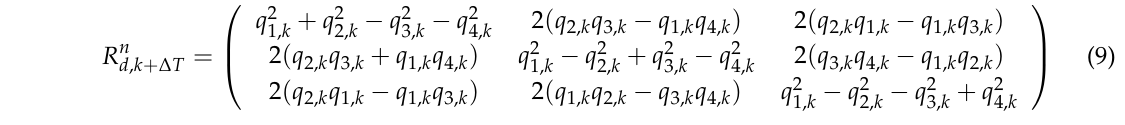
(cid:8) (cid:9) q q q q 1, k , 2, k , 3, k , 4, k